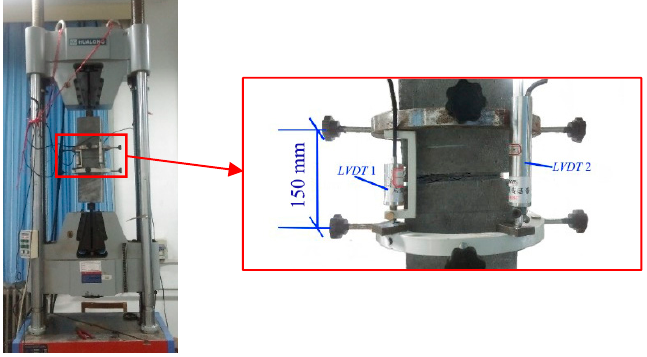
Figure 3. Testing machine and device for axial tensile strength of